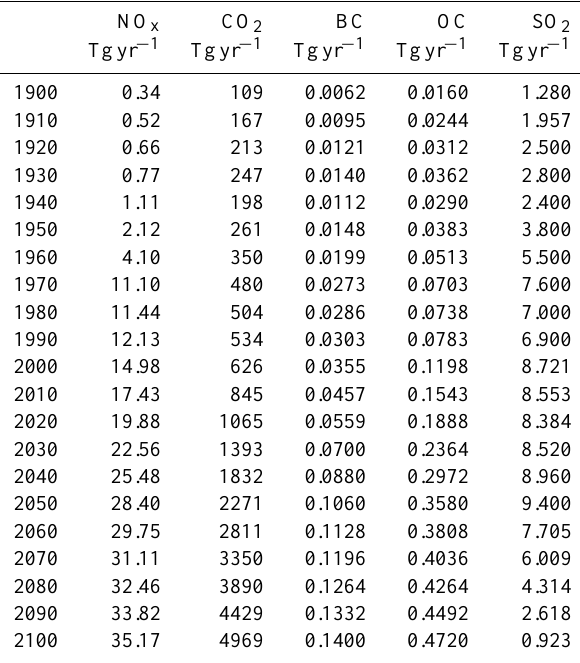
Table 2. Time series of maritime shipping emissions (Endresen Table 3. Time series of aviation emissions (Lee et al., 2010, http: